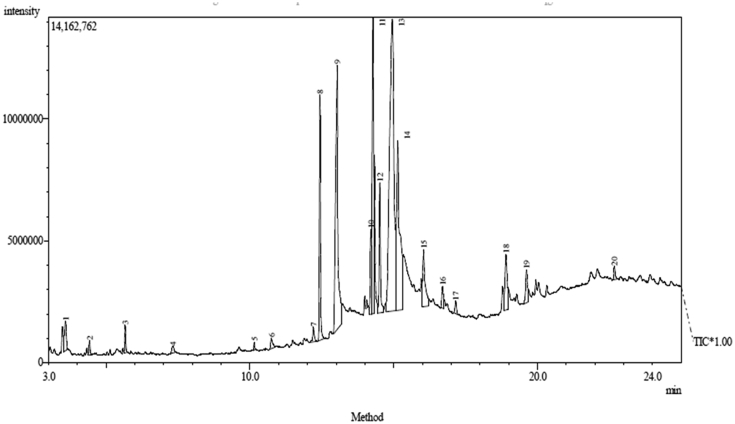
GC-MS chromatogram of ethyl acetate extract of the Carica papaya seed.